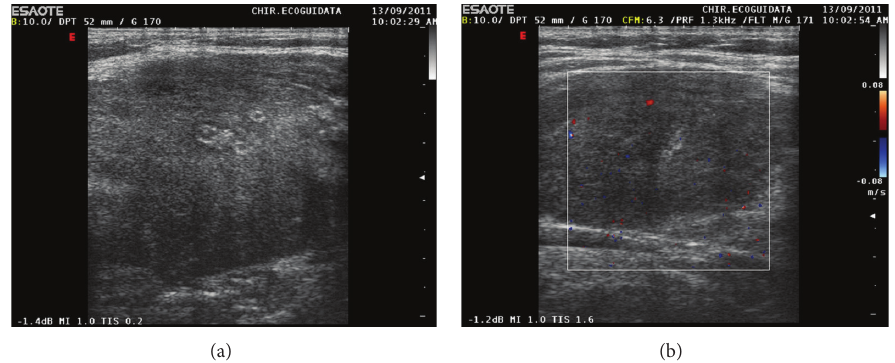
Figure 2: Ultrasound examination. (a) Longitudinal scan of the thyroid right lobe; the gland echogenicity is similar to that of the strap muscle. The postablative laser scares are clearly visible as “target like” focal areas inside the gland. (b) The color Doppler examination reveals a poor or absent vascular pattern.